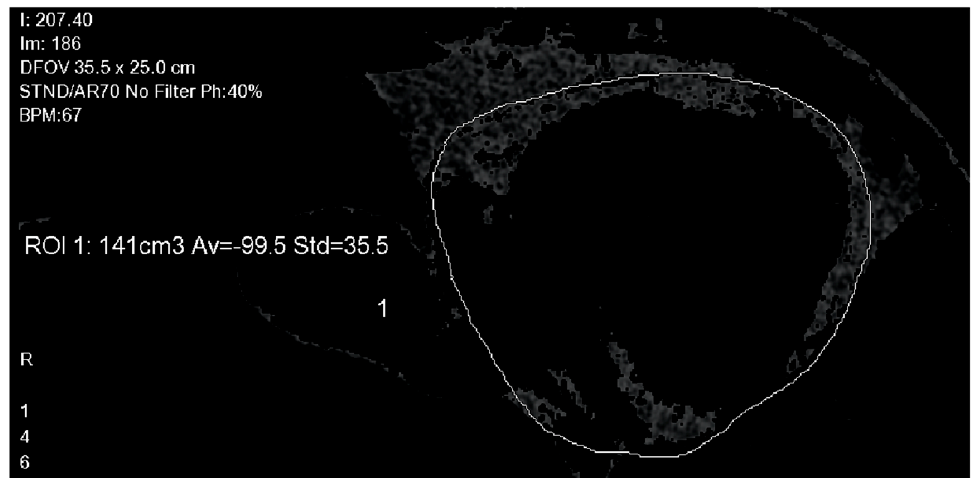
Figure 3. EAT measurement: contouring of the fibrous pericardium.